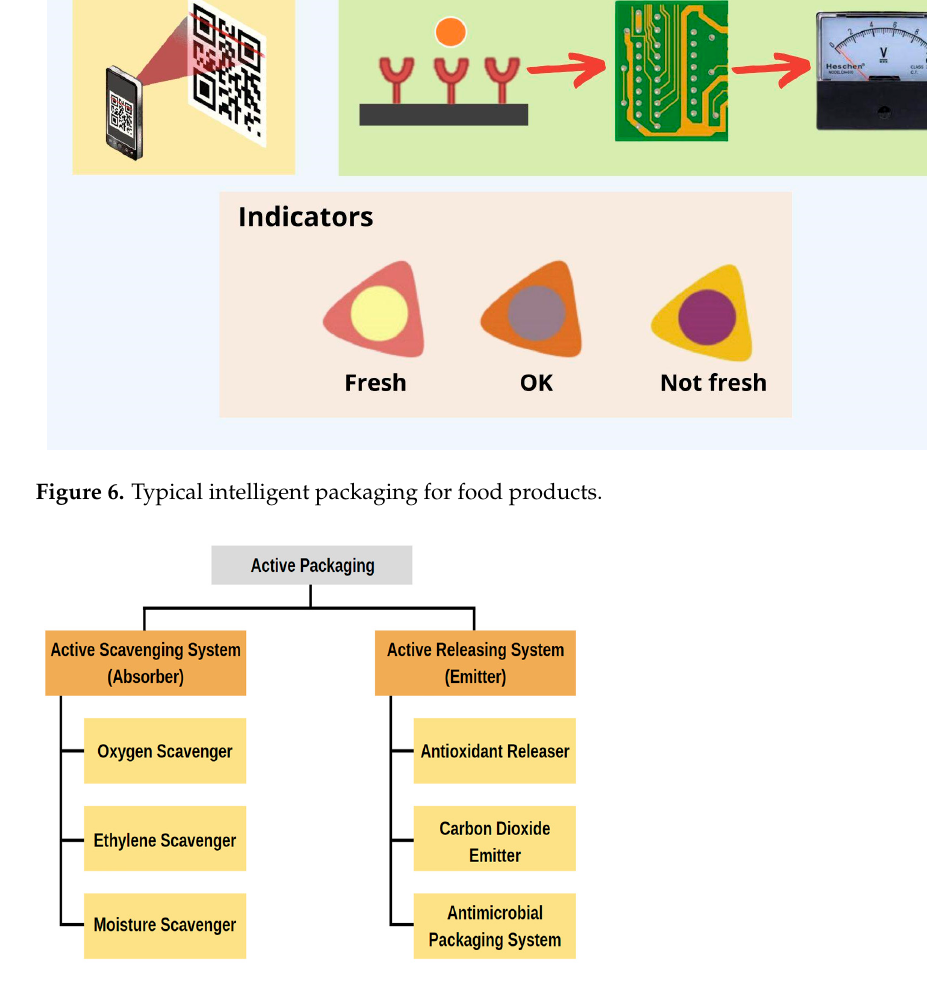
Figure 6. Typical intelligent packaging for food products.